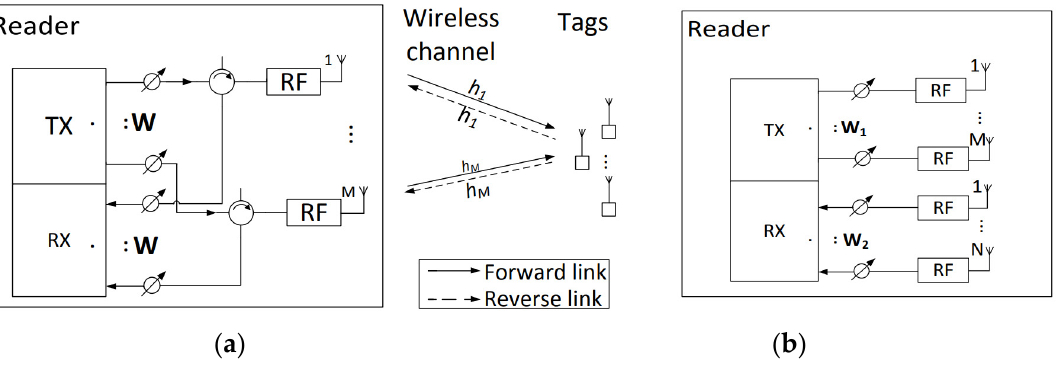
Figure 4. ( a ) Full duplex RFID Reader; ( b ) Half duplex RFID Reader. Reproduced from [32] with permission from IEEE.